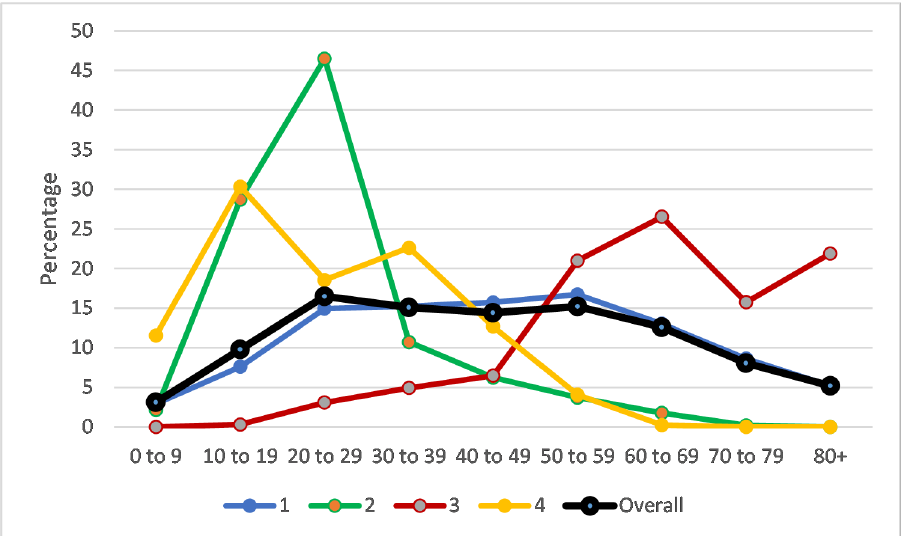
Figure 5. Percentage of individuals who fall into age categories for overall sample of 10,000 and for each of the four clusters. Same information as in Table 6.